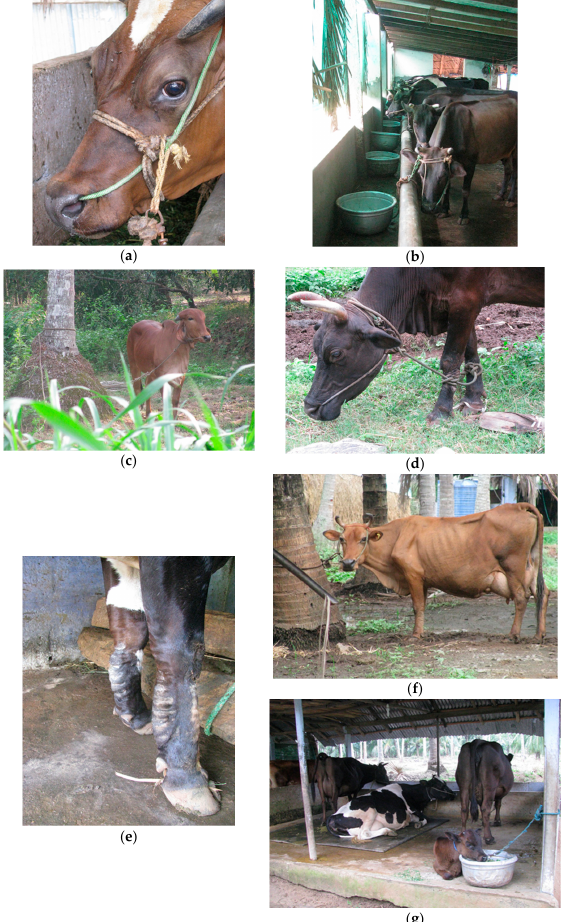
Figure 1. ( a ) The halter used on all cows, ( b ) close-tied in the shed, ( c ) longline tether, approx. 10 m ( Bos indicus heifer not in study population, choosing to stand near tree), ( d ) hobbled cow, ( e ) hobbling injuries, ( f ) close-tied outside, and ( g ) rubber mat under one cow.